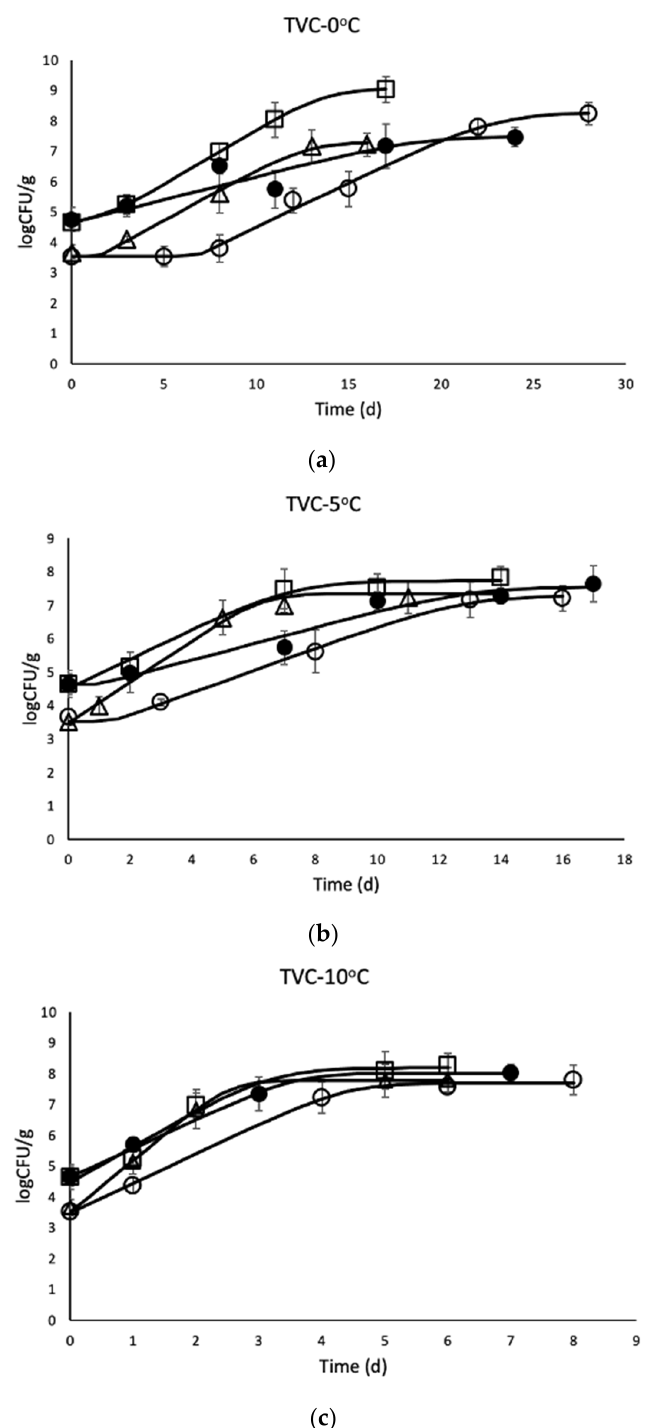
Figure 1. Enumeration of TVC in chicken stored at ( a ) 0 °C, ( b ) 5 °C, and ( c ) 10 °C ( (cid:1) control, ● MAP, ○ EC-flav, △ EC-glu).